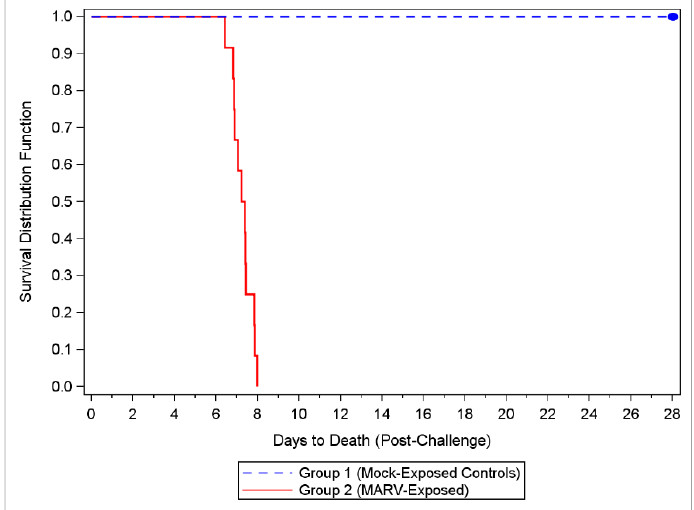
Figure 1. Kaplan–Meier Time to Death Plot. Twelve cynomolgus macaques were challenged with targeted dose of 1000 PFU of MARV Angola via IM injection. An additional six NHPs were injected with HBSS/2% HI-FBS and served as mock-challenge controls. All NHPs were observed at least twice daily for up to 28 days post-challenge.